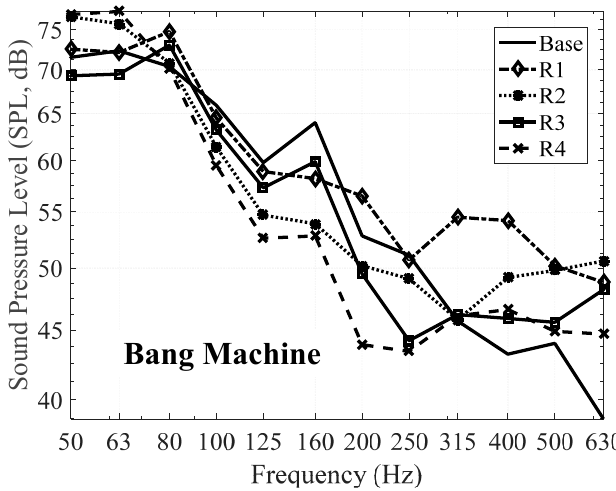
Figure 17. Floor impact sound level with the proposed materials in 1/3 Octave bands—Bang machine. Materials 2016 , 9 , 592